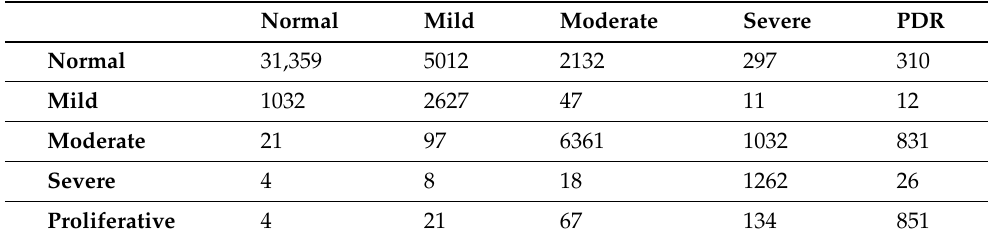
Table 7. Confusion matrix For CNN 2 (RGB Images), Accuracy =